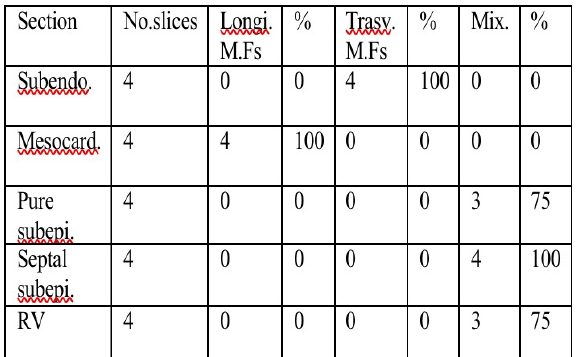
Table 3. Difference in the muscle fibers direction of VMS-layers in the cow heart.